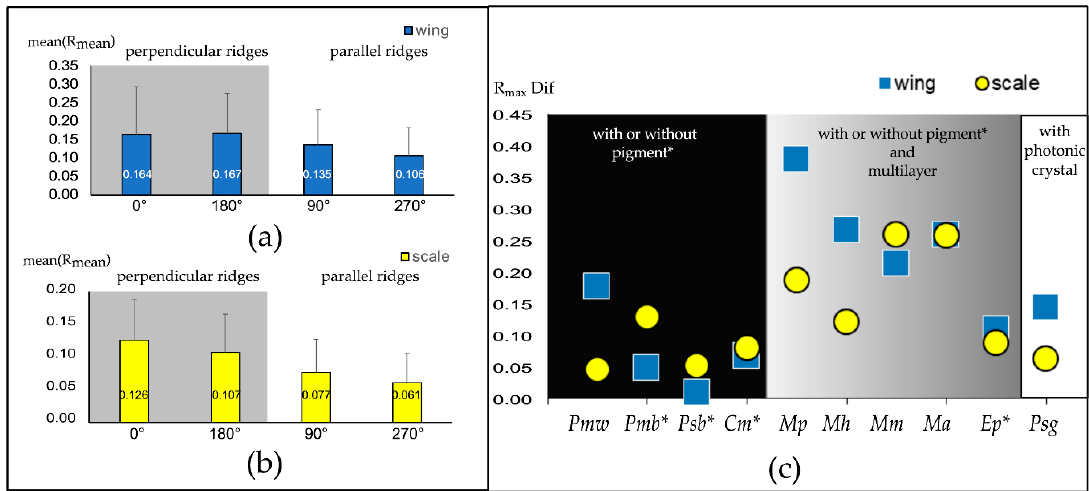
Figure 5. Mean orientation-dependent reflectance for all investigated butterfly species. The chart representing wing patches is in panel ( a ) and the chart representing single scales is in panel ( b ). The reflectance perpendicular to the ridges (0° and 180°) is higher than the reflectance parallel to the ridges (90° and 270°). Panel ( c ) displays the difference in orientation-dependent reflectance for the wing patches (blue squares) and single scales (yellow circles) ordered by increasing structural complexity of the scale ultrastructure and the dominant colouration mechanism. (species abbreviations see Section 2.1).